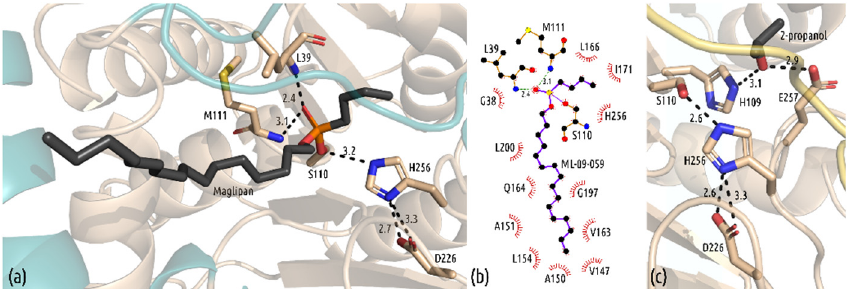
Figure 3. ( a ) Close-up view of the covalently bound substrate analog Maglipan, with interactions in the active site. The catalytic triad (S110, H256, D226) and the residues forming the oxyanion hole (M111, L39) are shown in stick representation. ( b ) Interactions of Maglipan with mtbMGL K74A calculated with Ligplot+. ( c ) 2-Propanol, found in the active site of mtbMGL K74 with closed-cap conformation. Interacting residues (H109, E257) are shown in stick representation; the catalytic triad is shown for orientation.